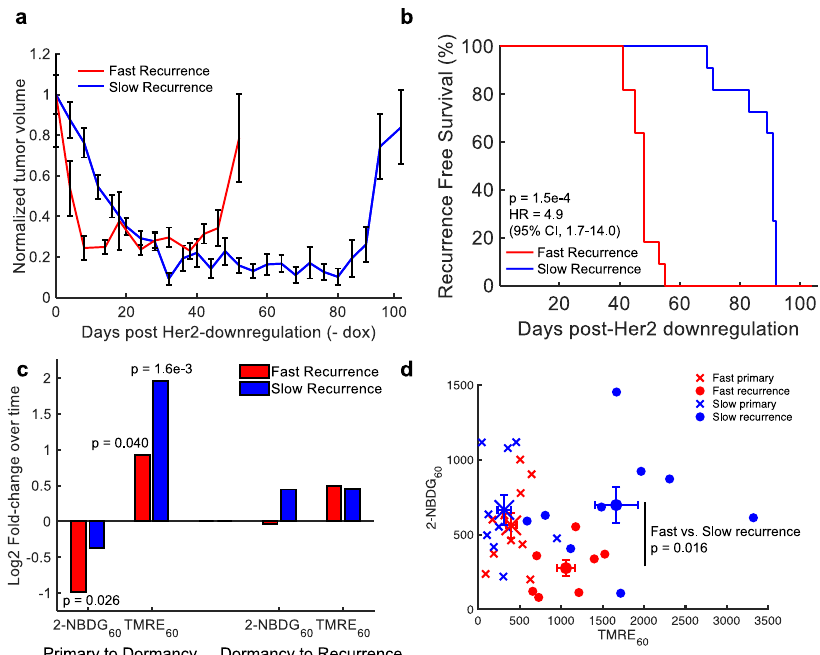
Fig. 3 Tumors varying in recurrence-free survival time show differences in glucose uptake at the primary, dormancy, and recurrent time points. a Normalized average tumor volumes during the dormancy cycle where 0 days represents primary tumors (Her 2 on). Error bar = standard error of the mean. ( n = 11 per tumor type). b Kaplan – Meier plot showing recurrence-free survival (RFS) for mice bearing fast or slow- recurrent tumors. Statistical comparison was determined by a Log-rank Test. (fast and slow, n = 11 mice). c Log2 fold-change in mean 2-NBDG 60 and TMRE 60 in primary tumors compared to dormant tumors (Log2 fold-change = Log2 (Mean DORMANCY /Mean PRIMARY )) and dormant tumors compared to recurrent tumors (Log2 fold-change = Log2 (Mean RECURRENCE / Mean DORMANCY )). d Average 2-NBDG 60 vs. TMRE 60 for each tumor line. Statistical comparisons of fold-changes were performed with a two-sided t -test that compared each time point. (fast and slow primary tumor mice, n = 10; fast and slow dormant tumor mice, n = 8; slow-recurrent mice, n = 9 and fast-recurrent mice, n =